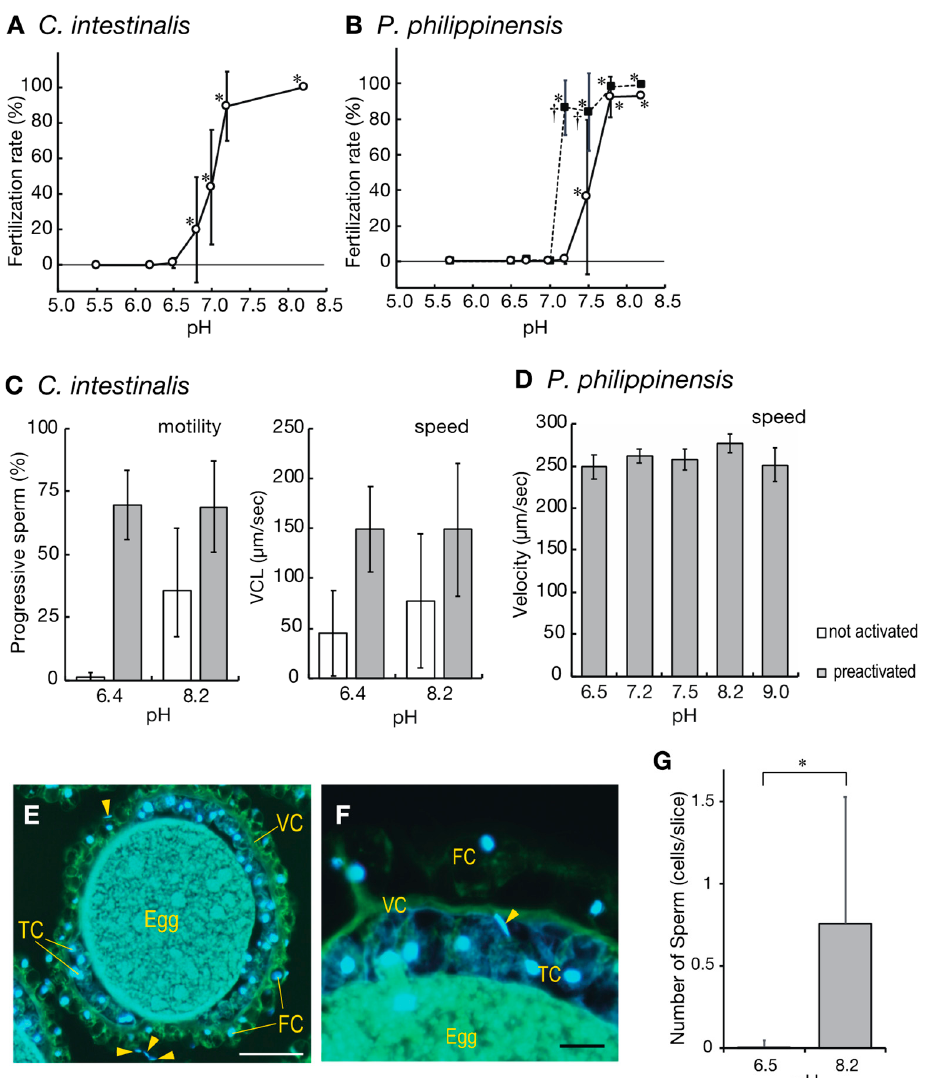
Figure 1. ( A , B ) Effects of pH on the fertilization rates of the ascidians Ciona intestinalis ( A ) and Phallusia philippinensis ( B ). Fertilization rates of eggs inseminated with intact sperm (open circle) or pre-activated sperm (closed square) at 3 h after insemination. Values are expressed as the mean ± standard deviation (SD) of four experiments. Asterisks indicate the point of statistical significance against the fertilization rate at pH 6.5 ( p < 0.05; Dunnett’s test). Daggers indicate the point that has statistical significance against the fertilization rate between activated and non-activated sperm ( p < 0.05; Student’s t -test). ( C , D ) Effects of pH on sperm motility in C. intestinalis ( C ) and P. philippinensis ( D ). White bars show non-activated sperm, gray bars show sperm pre-activated by 1 mM theophylline ( Ciona ) or pH 9.5 artificial seawater ( Phallusia ). VCL: curvilinear velocity. Speed was calculated from the progressively motile sperm. Values are expressed as the mean ± SD of four experiments. ( E – G ) Evaluation of sperm entry into the perivitelline space of the inseminated eggs of P. philippinensis. Eggs fixated 3 h after insemination were cut into 6- µ m-thick sections to observe the sperm inside the perivitelline space. Sperm nuclei stained with DAPI are rod-shaped (arrowhead) ( E , F ). Scale bars indicate 100 µ m ( E ) or 10 µ m ( F ) thickness. VC: vitelline coat; TC: test cells; FC: follicular cells. ( G ) Number of sections showing sperm nuclei in the perivitelline spaces of the inseminated egg at pH 6.5 and 8.2. Since a fixated egg consisted of an average of 18.3 sections (diameter of the egg: 110 µ m), the number of sperm penetrating the vitelline coat was estimated to be 13.9 sperm/egg at pH 8.2 and 0.04 sperm/egg at pH 6.5. Asterisks indicate statistical significance ( p < 0.05; Student’s t